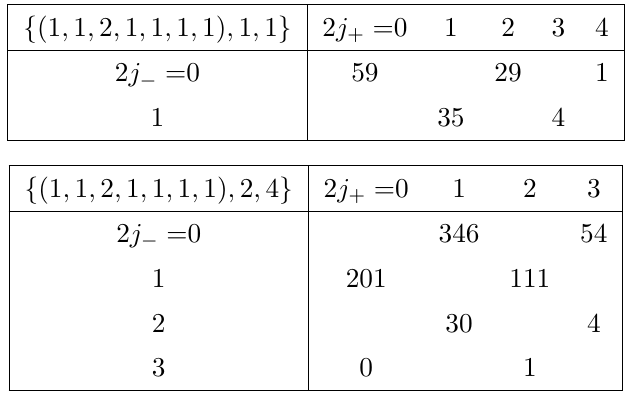
Table 12 . Refined GV invariants from (2,0) E 7 SCFT at base degree (1,1,2,1,1,1,1), fiber degree 1 and 2 with mass degree 1 and 4 respectively.